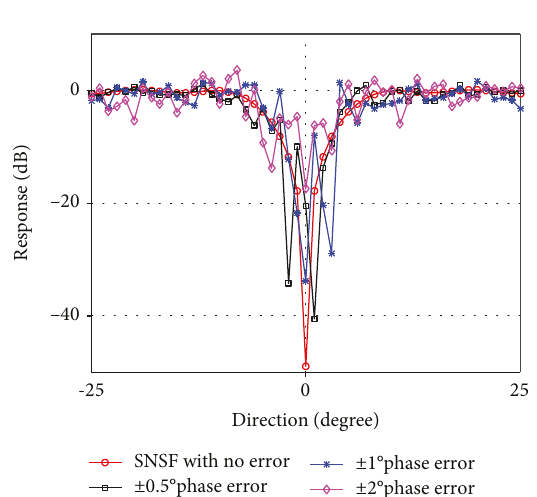
Figure 11: Response of the SNSF.